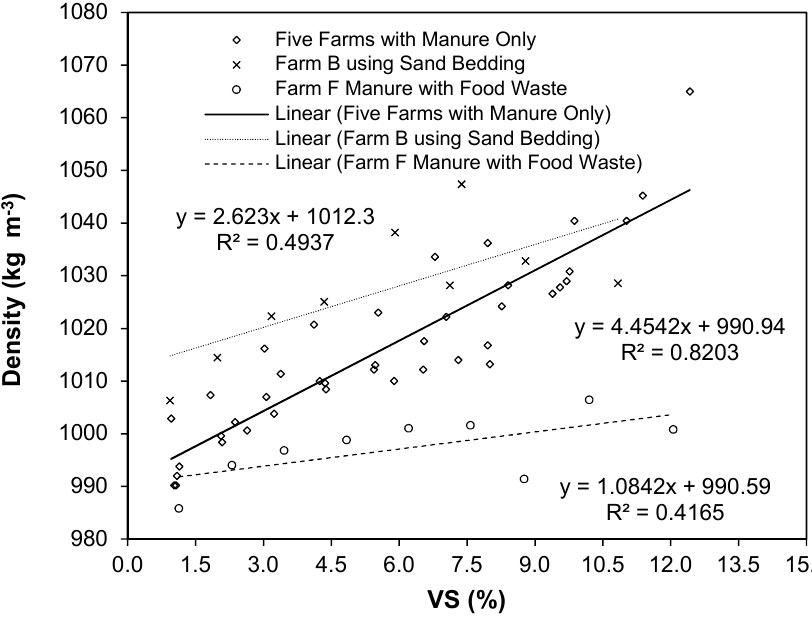
Figure 5. Density of pre-digested manure as a function of volatile solids (VS) content.